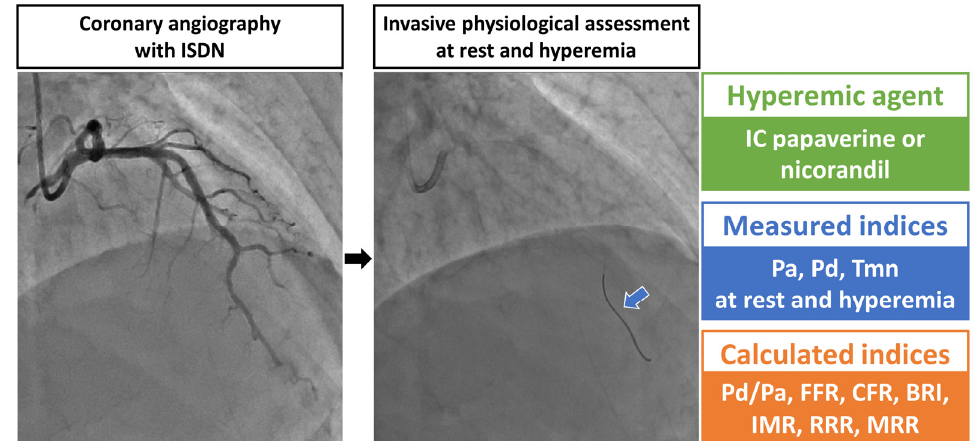
Figure 1. After administration of ISDN, coronary angiography was performed. Subsequently, the pressure sensor guidewire (PressureWire X, Abbot Vascular, Santa Clara, CA, USA) was advanced into the distal third of the left anterior descending artery after equalization. Three milliliters of room-temperature saline were injected into the left anterior descending artery at 3 times at rest, automatically calculating Tmn. Mean Pa and Pd were measured simultaneously. Tmn, Pa, and Pd were again measured under maximum hyperemia using intracoronary papaverine or nicorandil. Pd/Pa at rest, FFR, CFR, BRI, IMR, RRR, and MRR were calculated. A blue arrow indicates the pressure sensor guidewire. BRI, baseline resistance index; CFR, coronary flow reserve; FFR, fractional flow reserve; IC, intracoronary; IMR, index of microcirculatory resistance; ISDN, intracoronary isosorbide dinitrate; MRR, microvascular resistance reserve; Pa, mean aortic pressure; Pd, mean distal coronary pressure; RRR, resistance reserve ratio; Tmn, mean transit